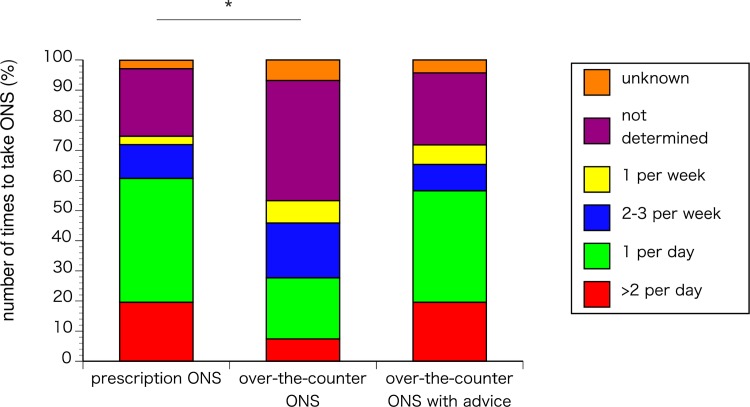
Number of times to take ONS.*p<0.0001.